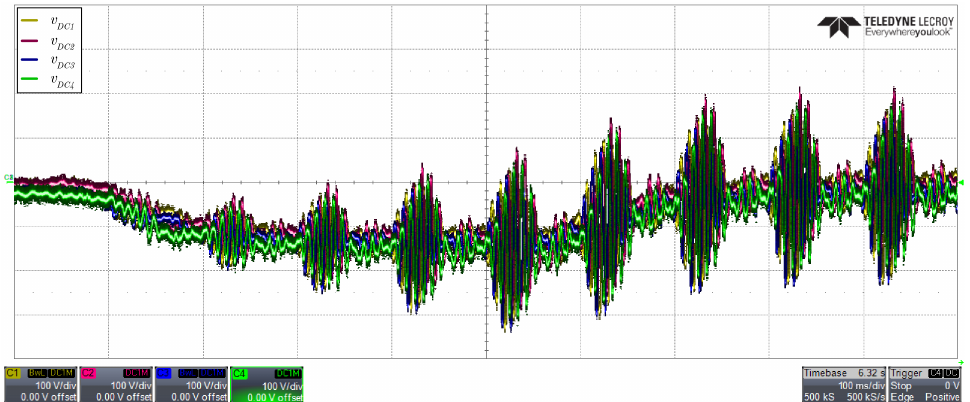
Figure 20. Transient response showing the arms DC voltages for a ramp from 0% to 100% of power injected into port 2 of the